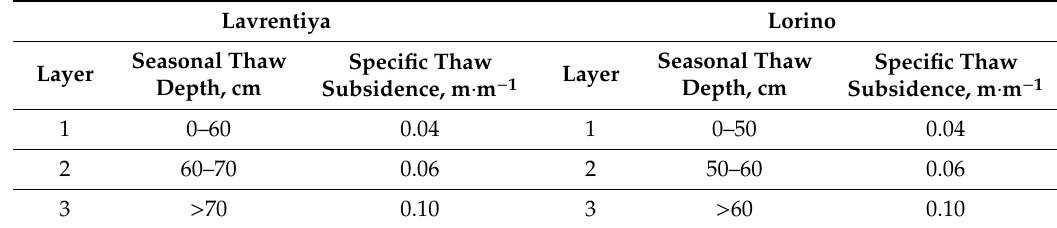
Table 4. Parameters used for predicted thaw subsidence